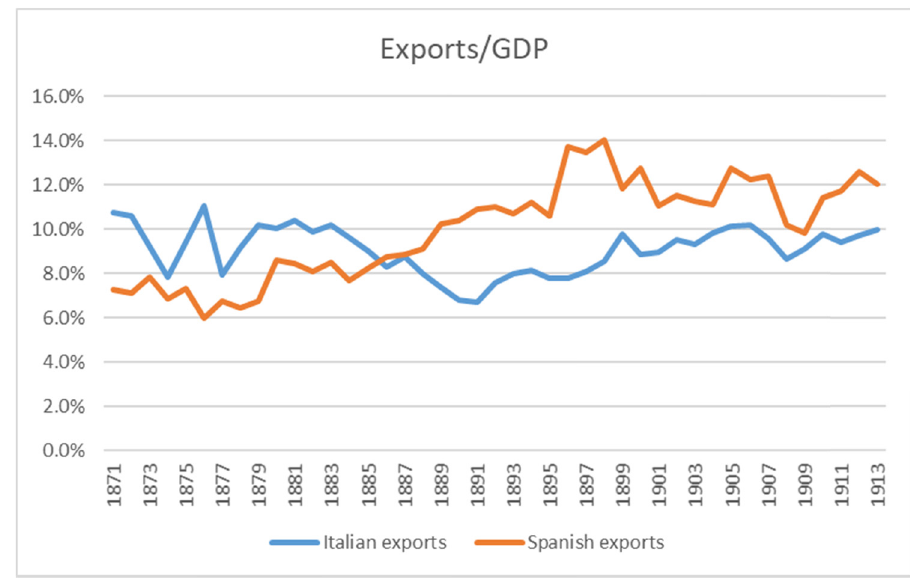
Figure 10: Exports over GDP in Spain and Italy. Sources: Ba ffi gi ( 2013 ) and Prados de la Escosura ( 2017 )